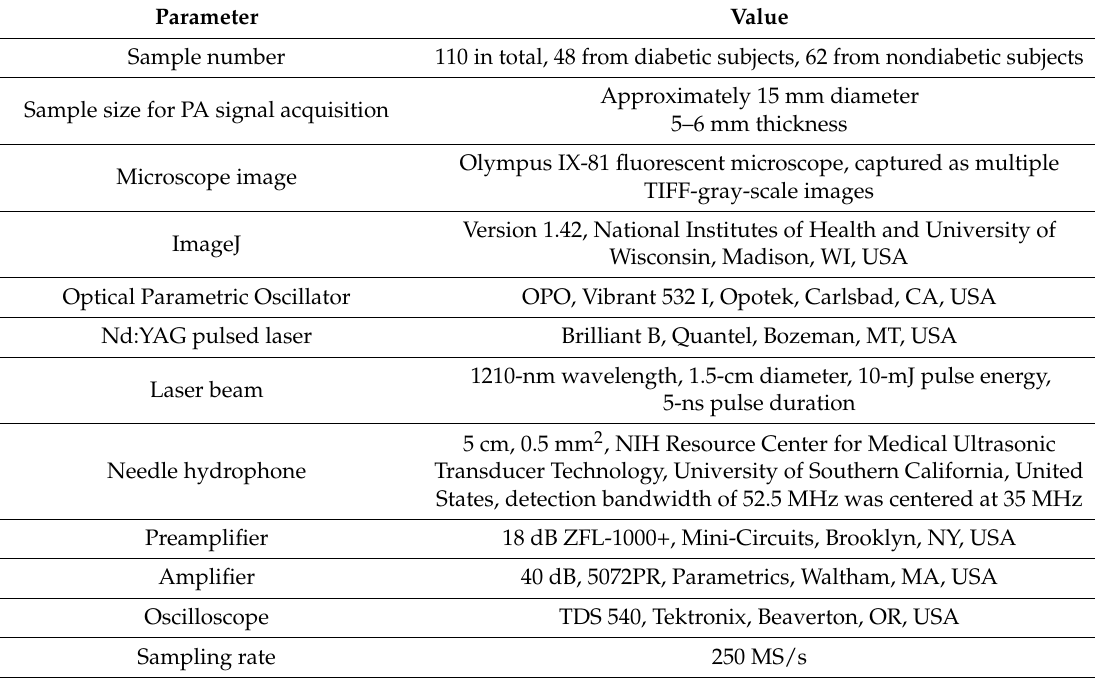
Table 1. Experiment parameter setting.